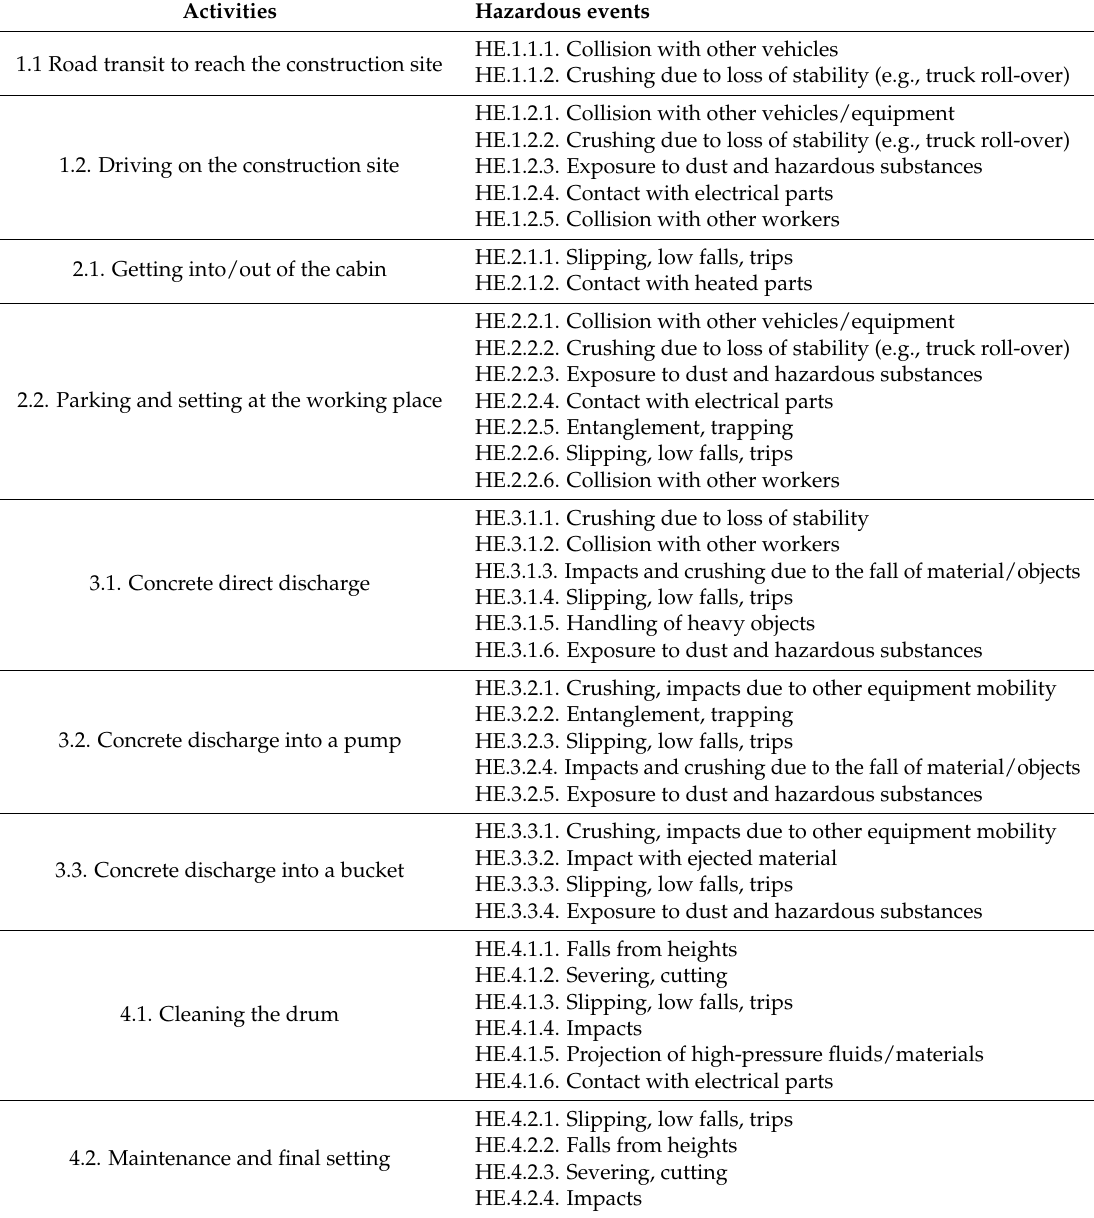
Table A1. List of the hazardous situations/events